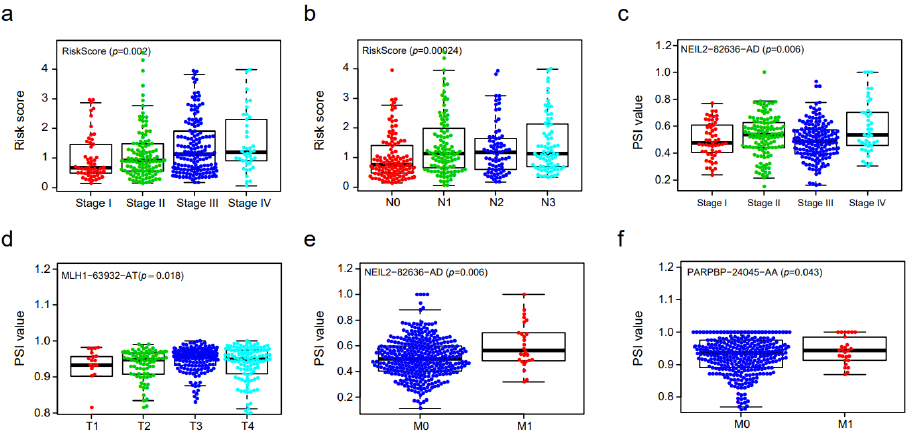
Figure 5. Correlation between the PSI value of prognosis-related DNA repair gene alternative splicing and clinical traits. ( a – f ) Box plot is shown. ( a , b ) Risk score in different TNM stages. ( c , d ) The PSI values of NEIL2-82636-AD and MLH1-63932-AT in different TNM stages. ( e , f ) The PSI values of NEIL2-82636-AD and PARPBP-24045-AA in different M stages. 3.6. Differentially Expressed Prognosis-Associated DNA Repair Genes